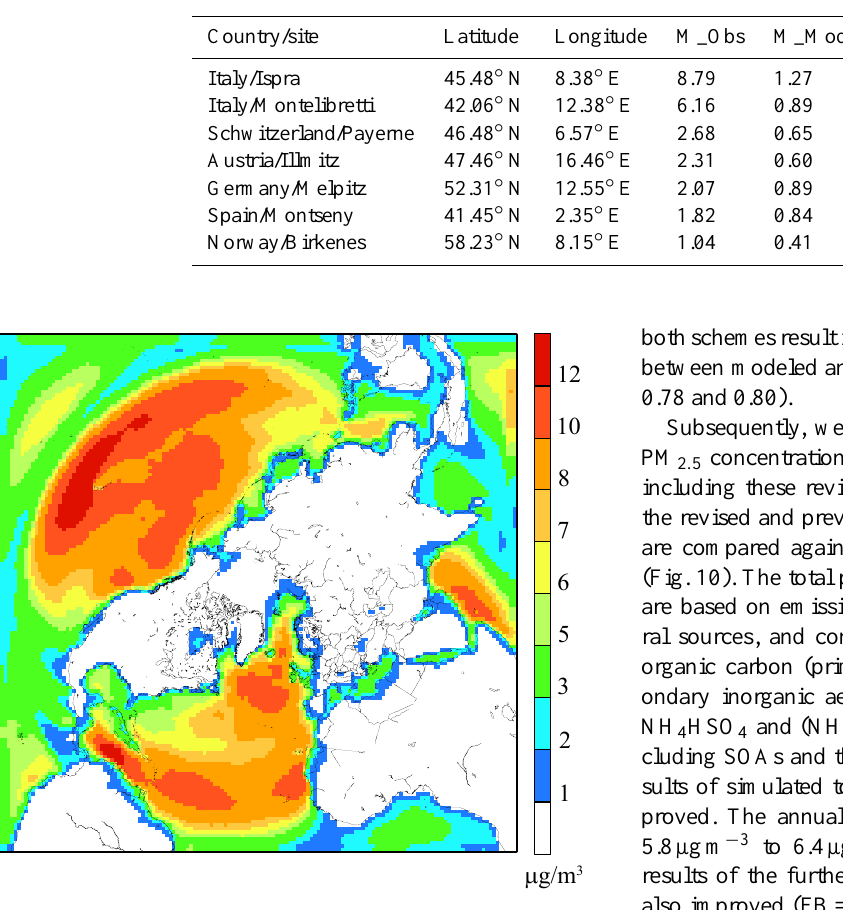
Fig. 8. Annual mean concentrations (µgm − 3 ) of sea salt in 2006 calculated by DEHM using combined source functions based on Mårtensson et al. (2003) and Monahan et al.